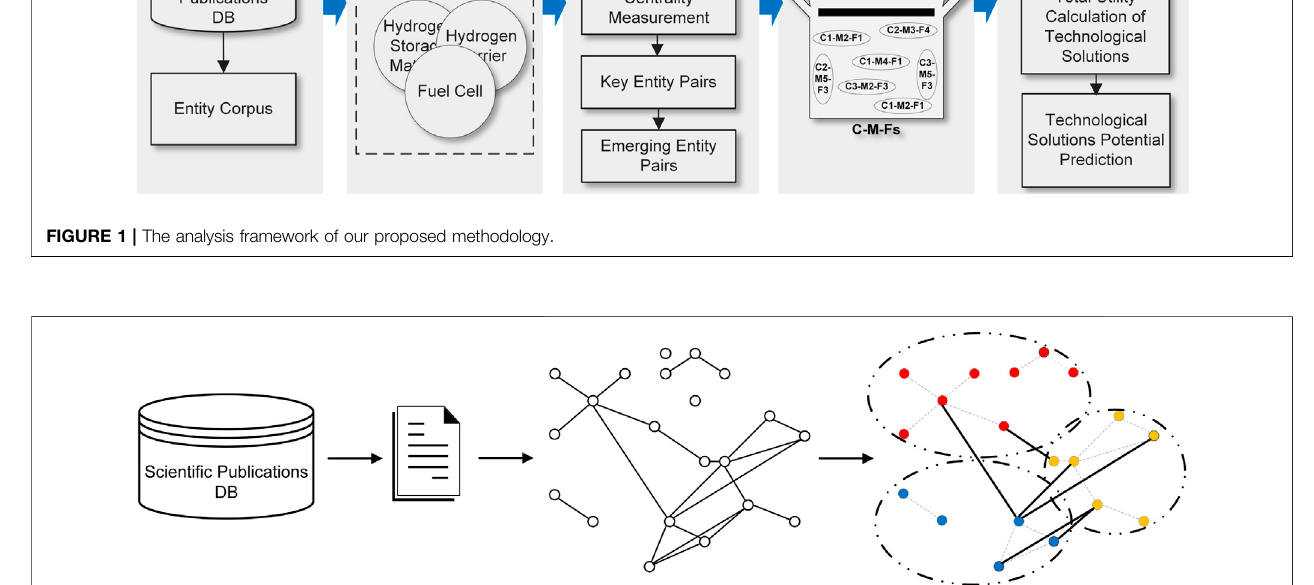
Frontiers in Energy Research |